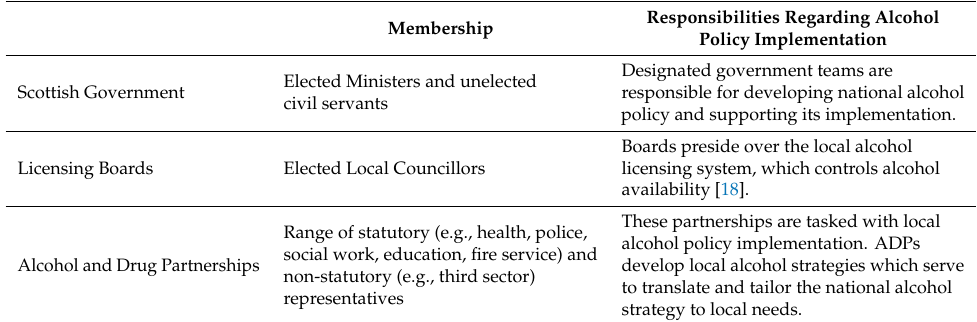
Table 1. Membership and Responsibilities of Scottish Alcohol Policy Implementation